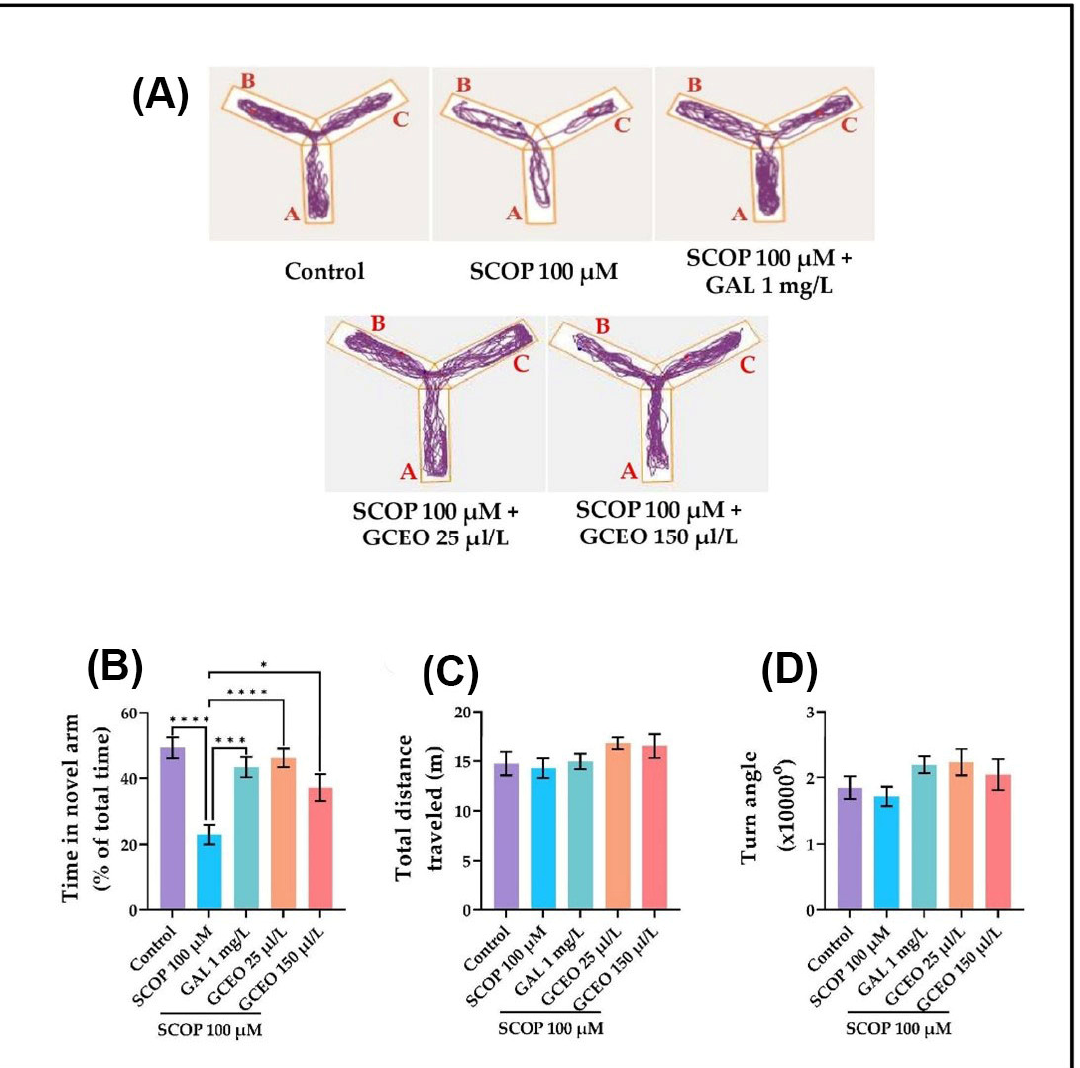
Figure 3. Y-maze task results for Glaucosciadium cordifolium essential oil (GCEO, 25 and 150 µL/L). ( A ) The representative locomotion tracking patterns of the zebrafish in the Y-maze task. ( B ) The time spent in the novel arm of the Y-maze. ( C ) Total distance traveled (m). ( D ) Turn angle (°). The start arm was marked with A, the other arm was marked with B, and the novel arm was marked with C. Data are expressed as mean ± S.E.M. ( n = 10). One-way ANOVA revealed overall significant differences between groups in ( B ) F(4,45) = 10.32, p < 0.0001. For Tukey’s post hoc analyses, **** p < 0.0001, *** p < 0.001 and * p < 0.05.